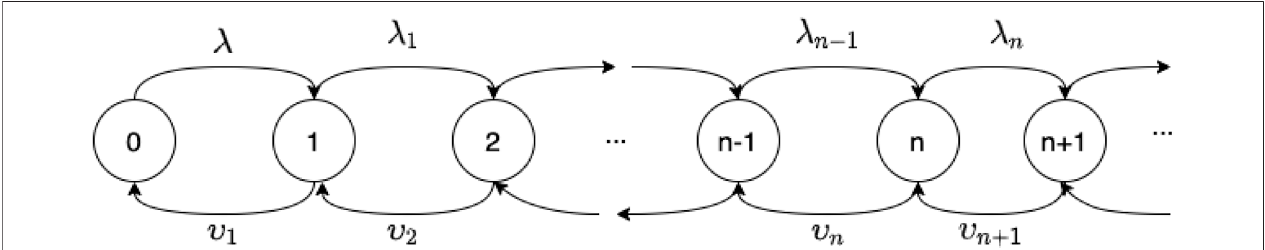
FIGURE 4 | Continuous-time birth-and-death process state